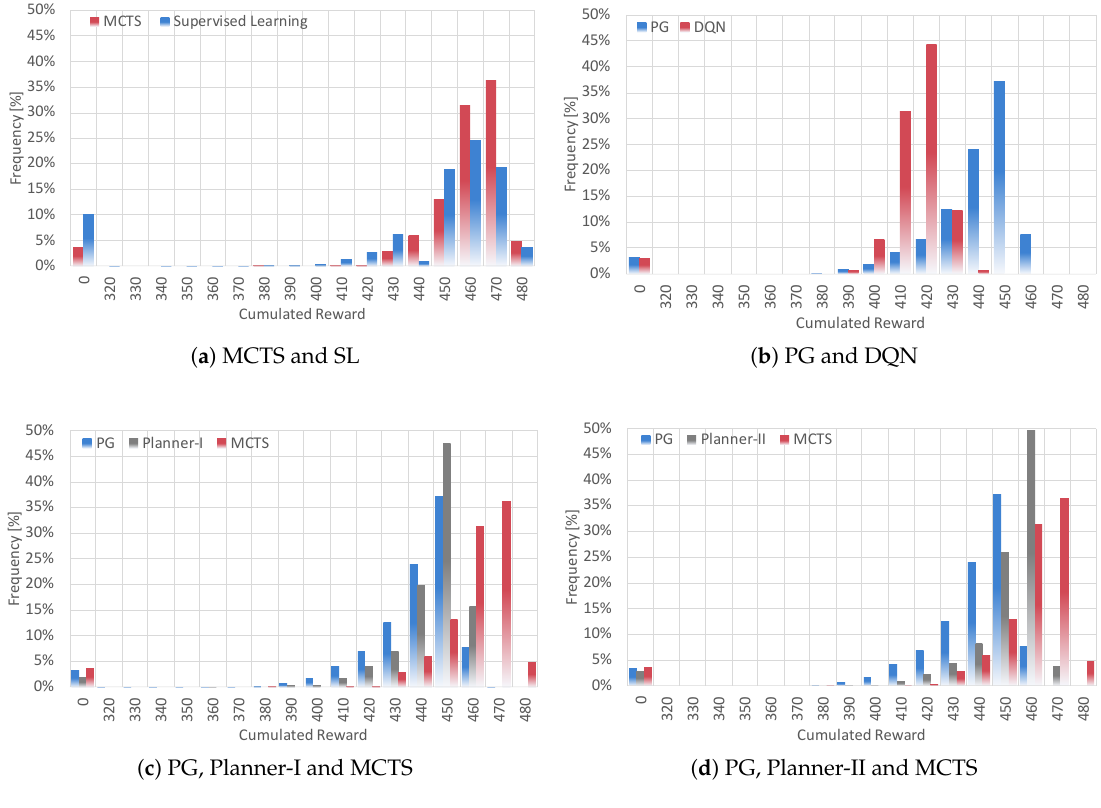
Figure 8. Comparison of the algorithms’ performance on the long run. Table 5. Statistic performance of all the